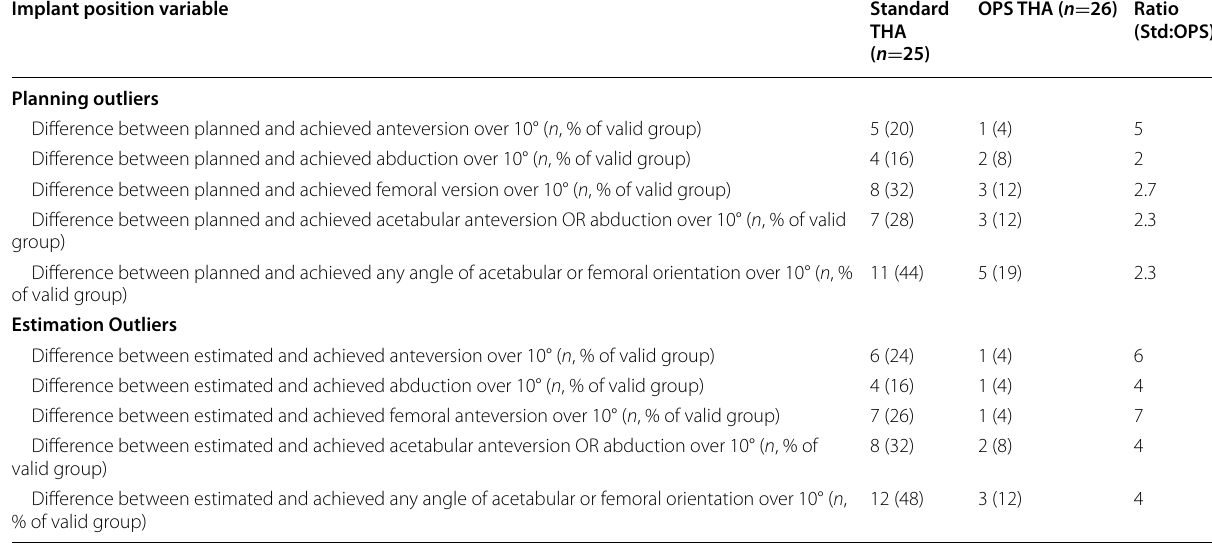
Table 2 Difference between planned or (intraoperative) estimated and achieved component position with reference to 10 degree outlier